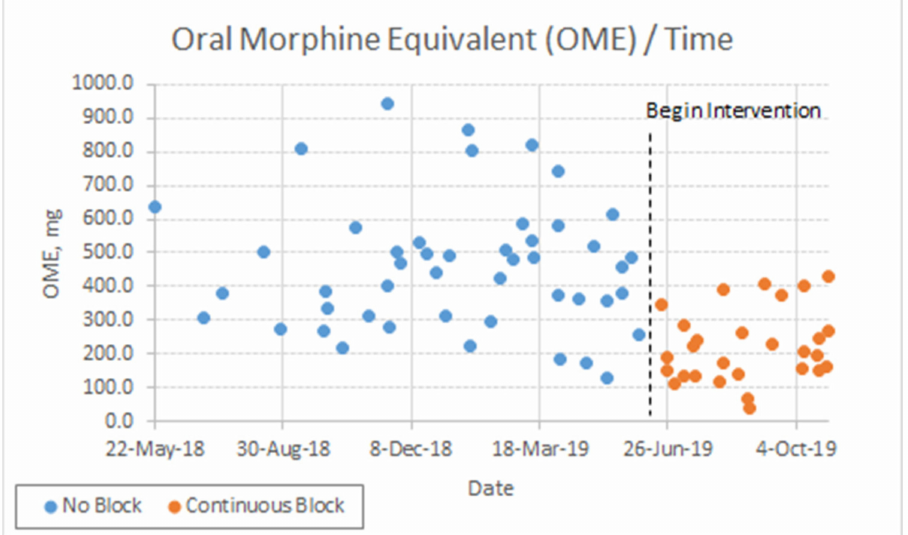
Figure 2. Total opioid consumption during hospitalization through postoperative day 5 per case in mg oral morphine equivalents (OME) over